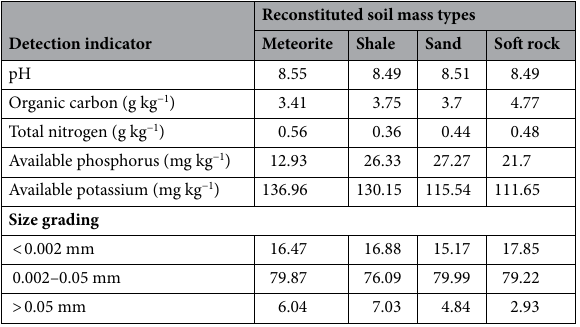
Table 1. Basic physical and chemical properties of four reconstructed soils at 0 ~ 20 cm